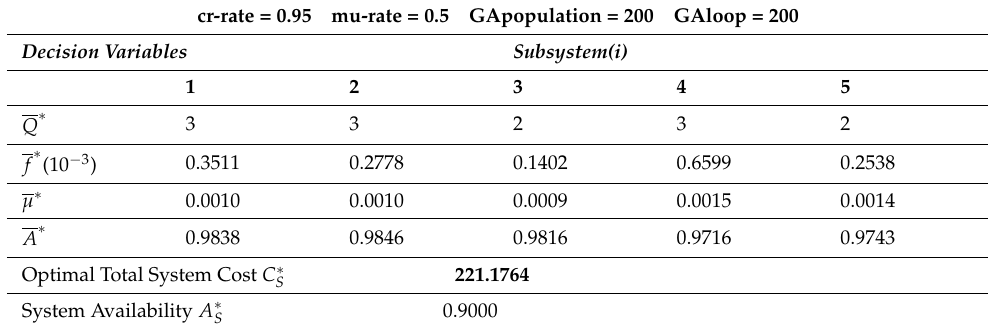
Table 38. Optimal Solutions obtained by TA–MGA combined method for the n -stage mixed sys- tem.